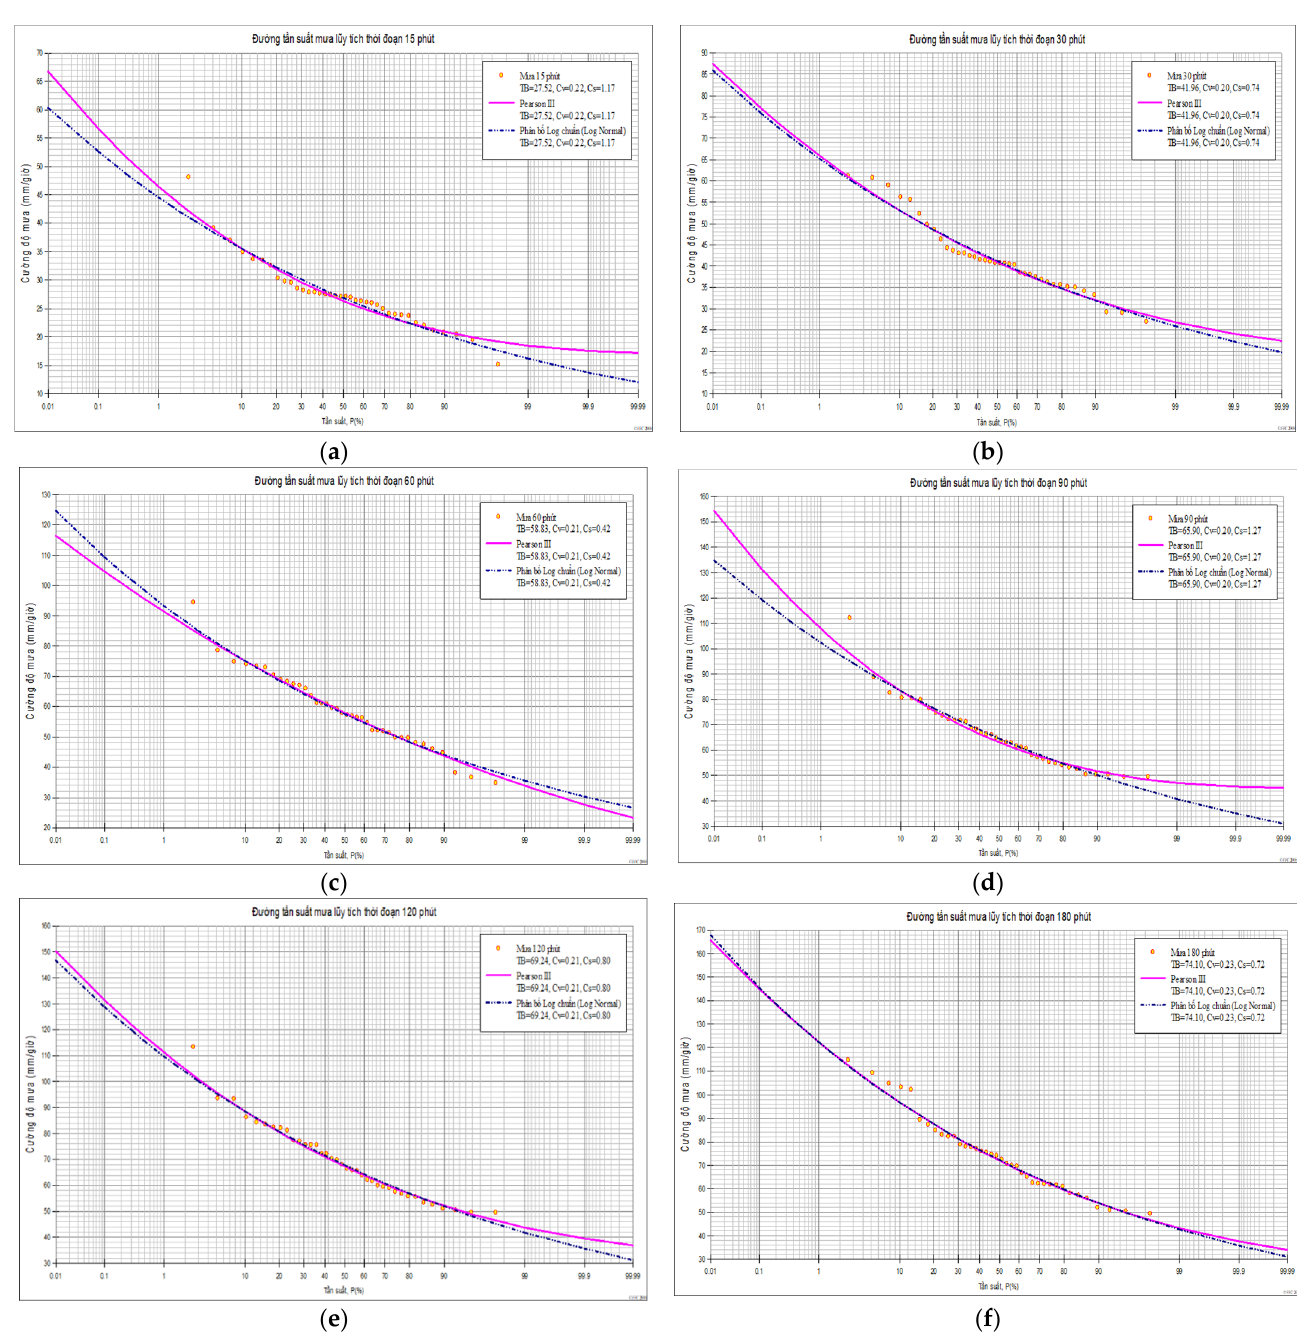
Figure A1. Distribution curve of CDF various duration according to P.III. CDF rainfall curve of